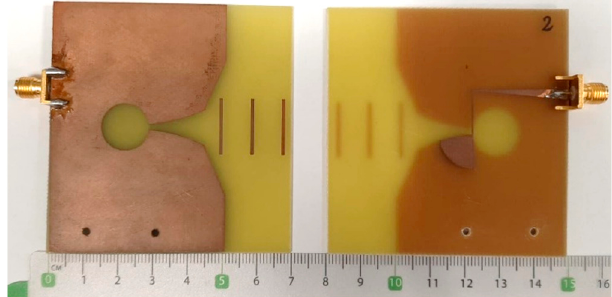
Figure 2. Designed Vivaldi-like antennas: top ( left ) and bottom ( right ).